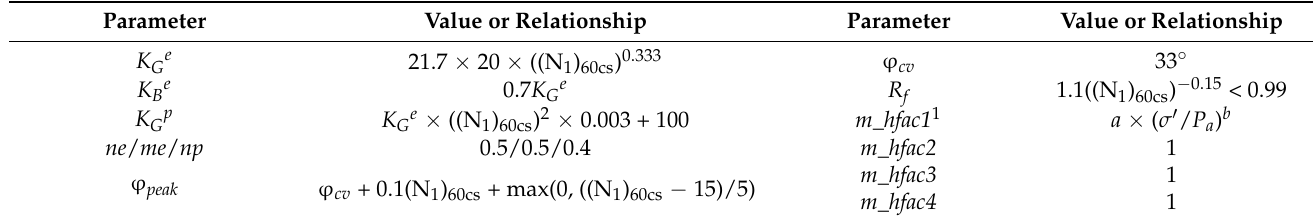
Table 3. Calibrated parameters of the UBCSAND model [19].